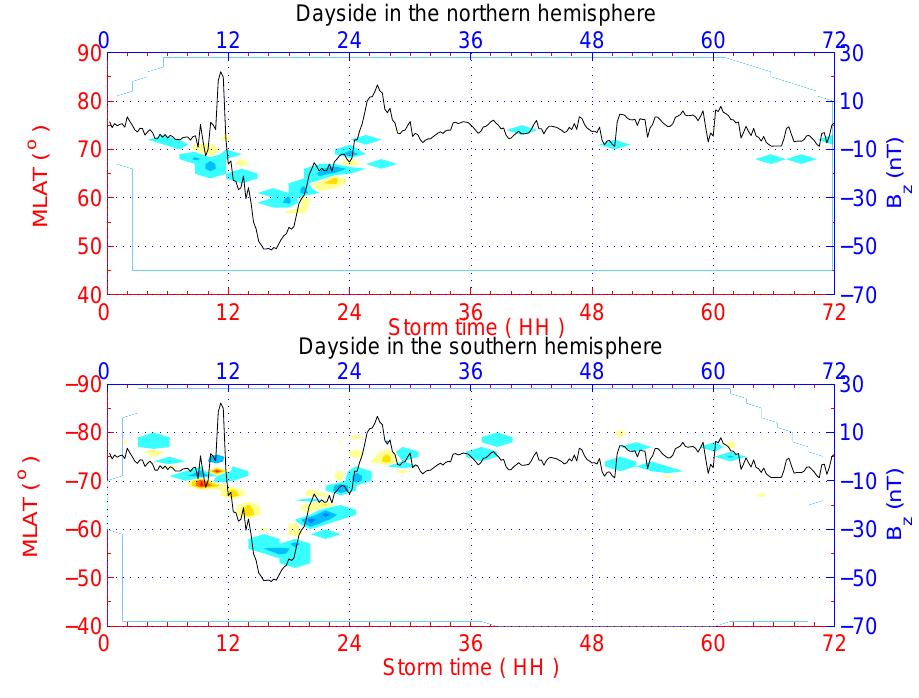
Fig. 8. Same as Fig. 4 but for November